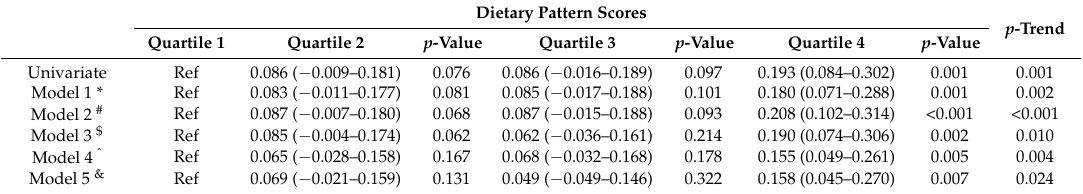
Table 4. Adjusted linear regression of the relationship between the quartiles of dietary pattern score levels and log-transformed RBC